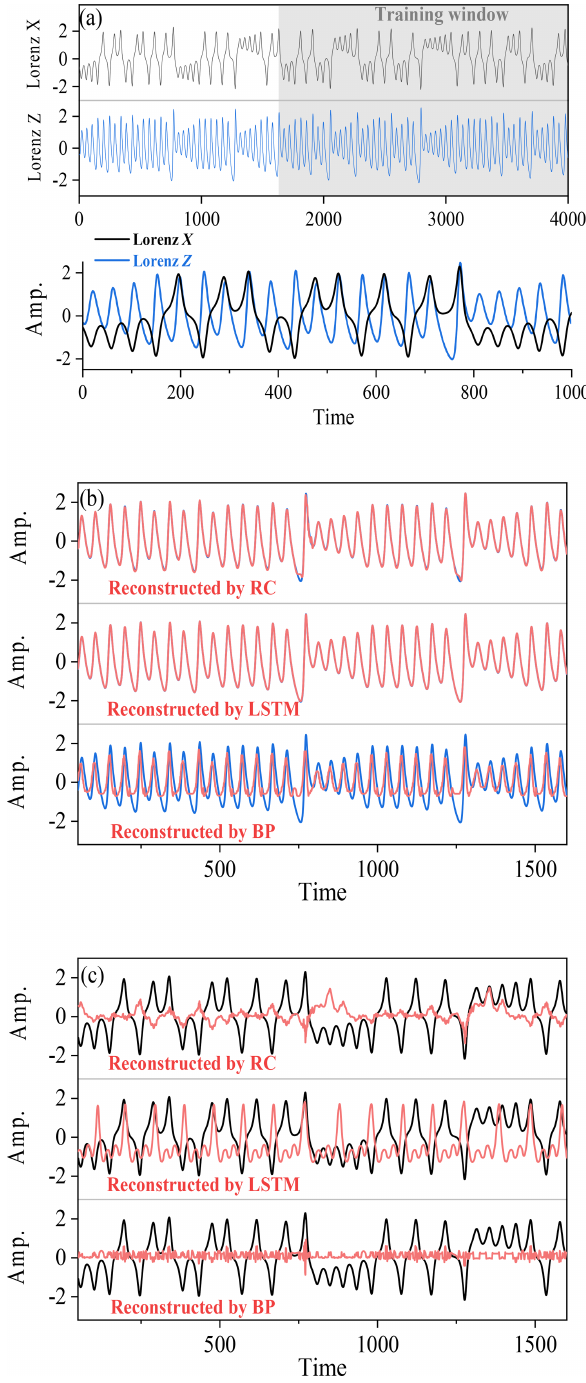
Figure 5. (a) The X time series (black) and the Z time series (blue) of the Lorenz 63 model. (b) Comparison of the reconstructed time series of Z (red) through RC, LSTM, and BP. Blue lines denote the real Z ( t ). (c) Comparison of the reconstructed time series of X (red) through RC, LSTM, and BP. Black lines are the real X ( t